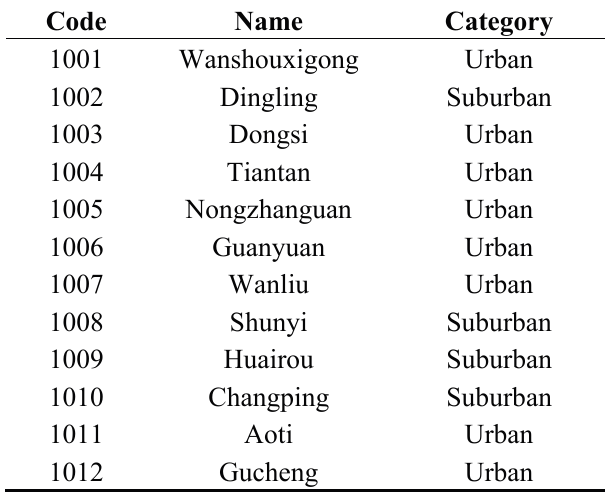
Table 1. Codes, names and categories of the 12 stations.